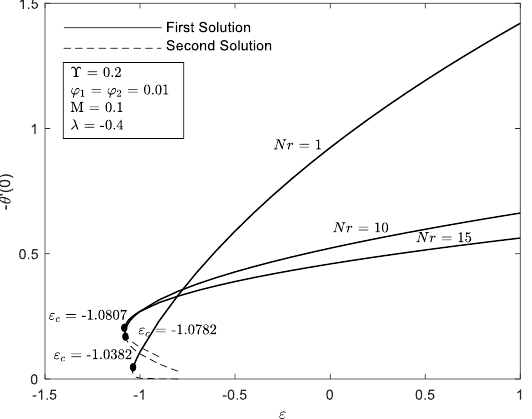
1 1 1 1 2 for several ϕ 1 with ϕ 2 . 2 for several 𝜑 1 with 𝜑 2 . 2 for several 𝜑 1 with 𝜑 2 . 2 for several 𝜑 1 with 𝜑 2 .